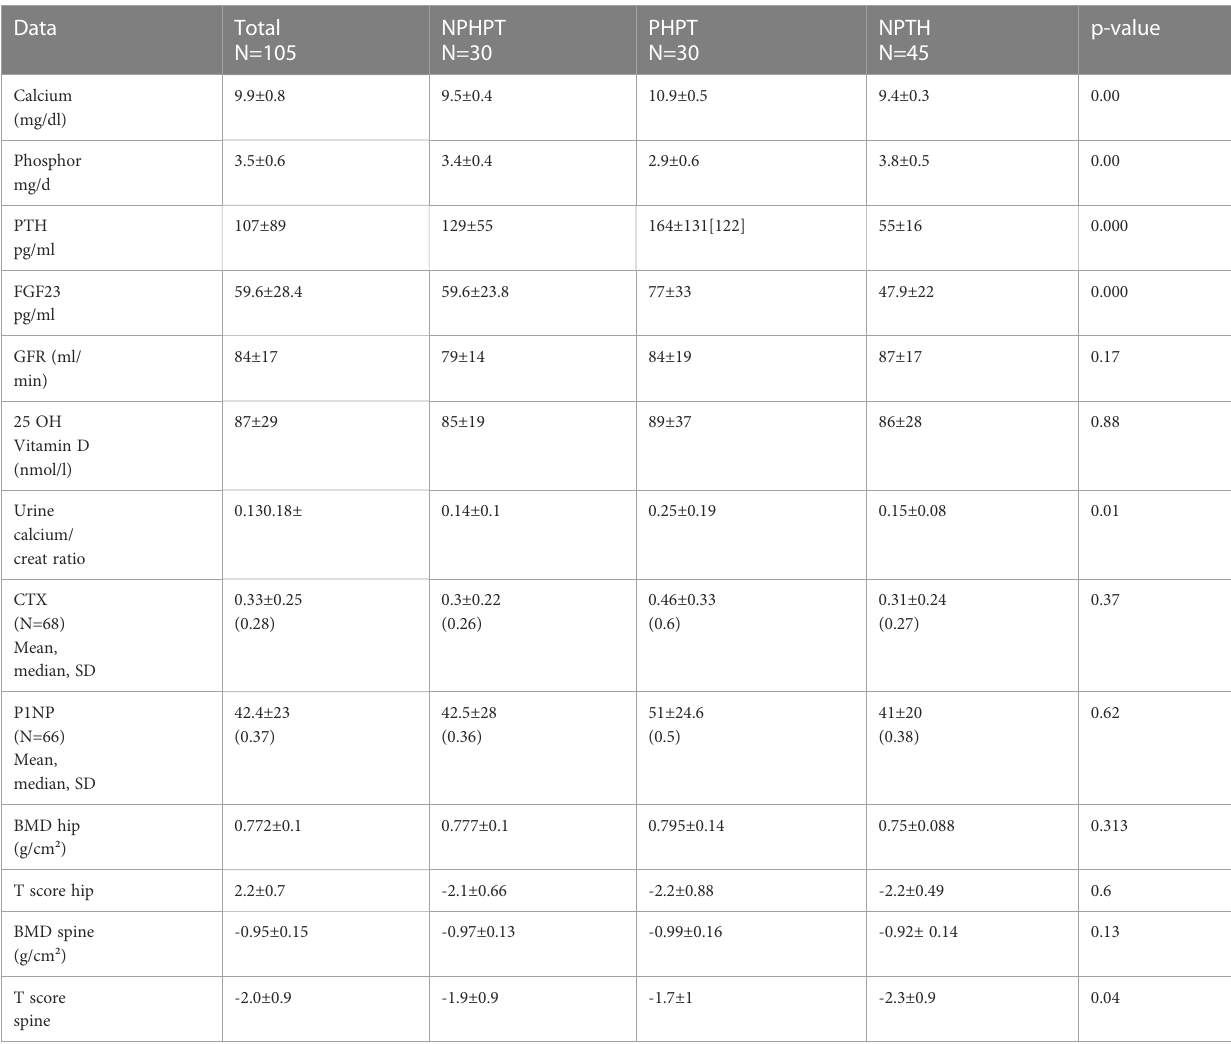
TABLE 2 Biochemical data and bone densitometry